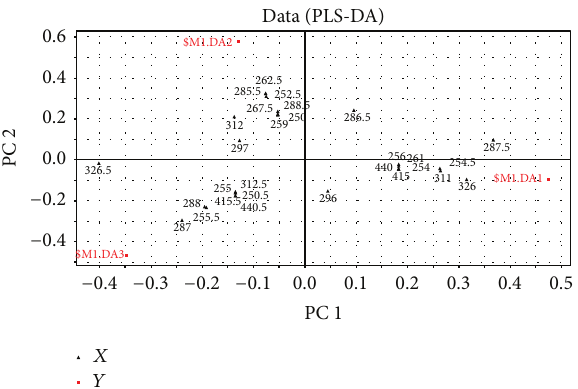
Figure 8: Loading plot generated from the PLS-DA model of the W. extensa